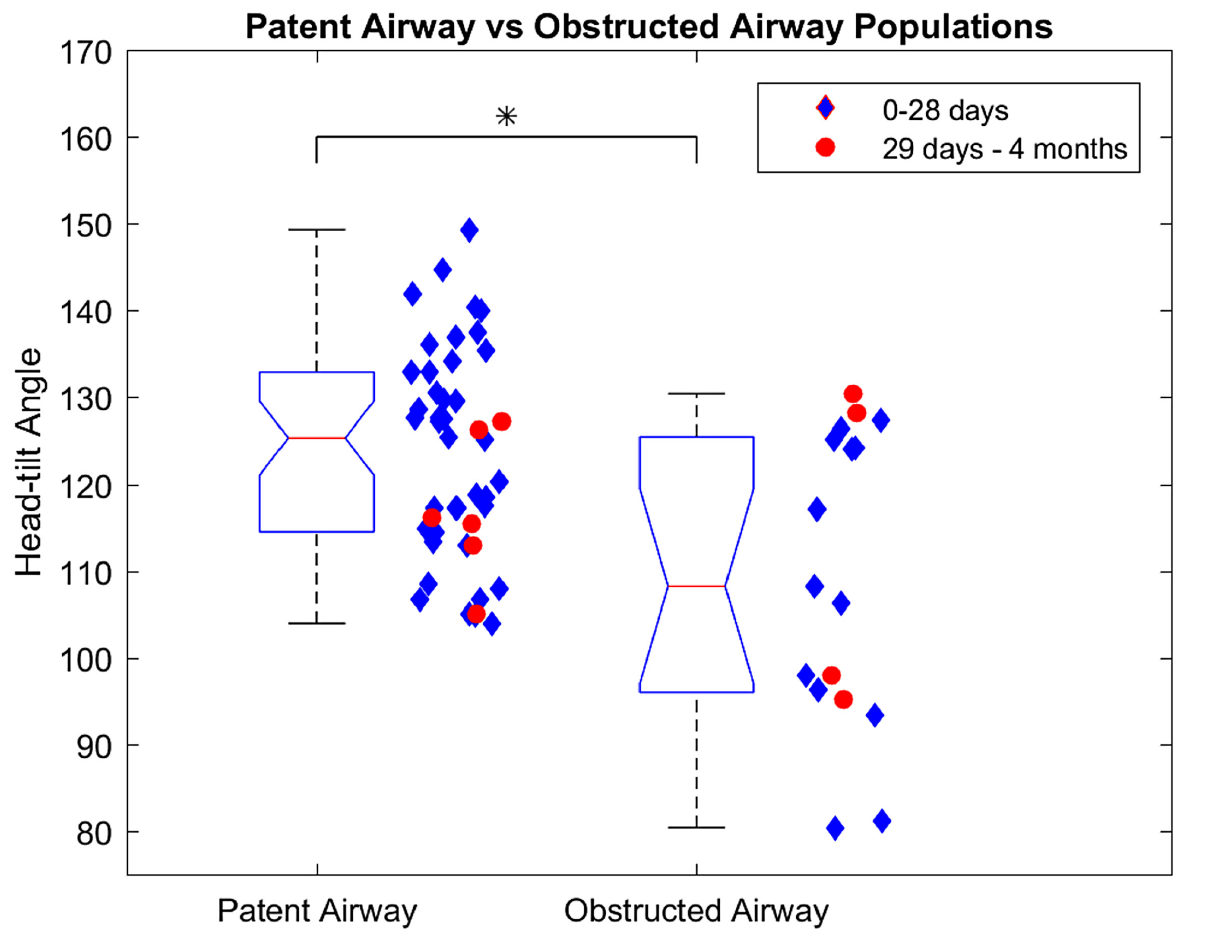
Fig 3. Box-plot diagram of head-tilt angle of patent airway as compared to that of obstructed airway. The median head-tilt angle associated with patent airway (125.3° ± 11.9°) was significantly different from median head-tilt angle (108.2° ± 17.1°) associated with an obstructed airway (p = 0.0045).